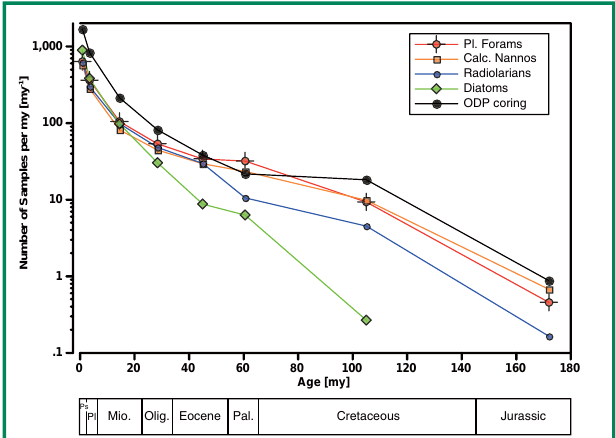
Figure 3. Number of MRC samples / my vs. age interval, log plot and summary of ODP core recovery by age. Core information was derived from preliminary Initial Reports data set covering Legs 101– 159 only, courtesy of